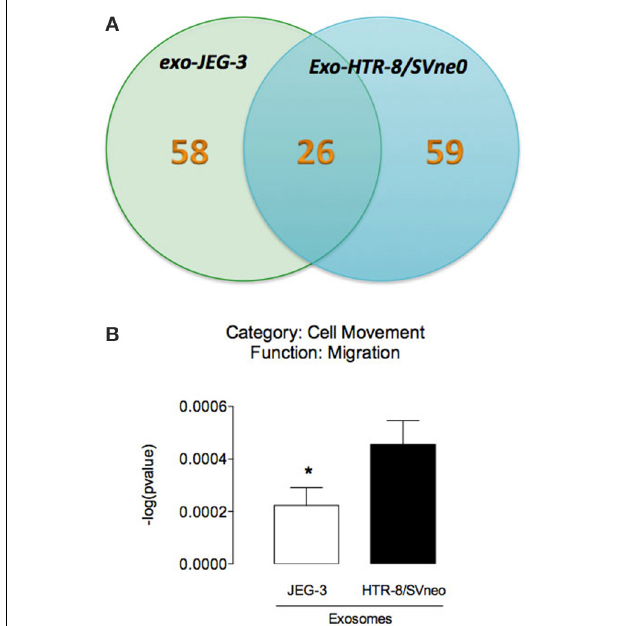
FIGURE 5 | Analysis of EVT cell-derived exosomes proteins. (A) The Venn diagram represents the distribution of common and unique proteins identified by nanospray LC-MS/MS (ABSciex 5600) in exosomes released from JEG-3 and HTR-8/SVneo cells. (B) Comparison of biological function (cell movement and migration) identified by IPA core analysis. In (B) values are mean ± s.e.m. In (B) ∗ p < 0 . 05 vs. HTR-8/SVneo